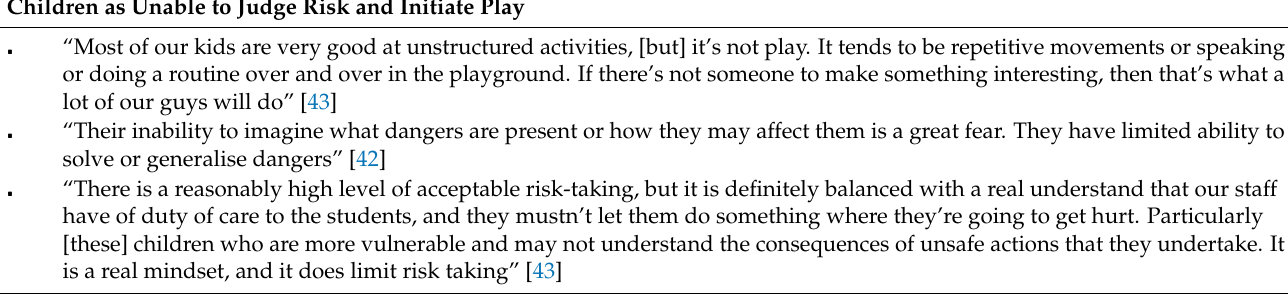
Table 4. Synthesised finding 2: Perceptions of children.